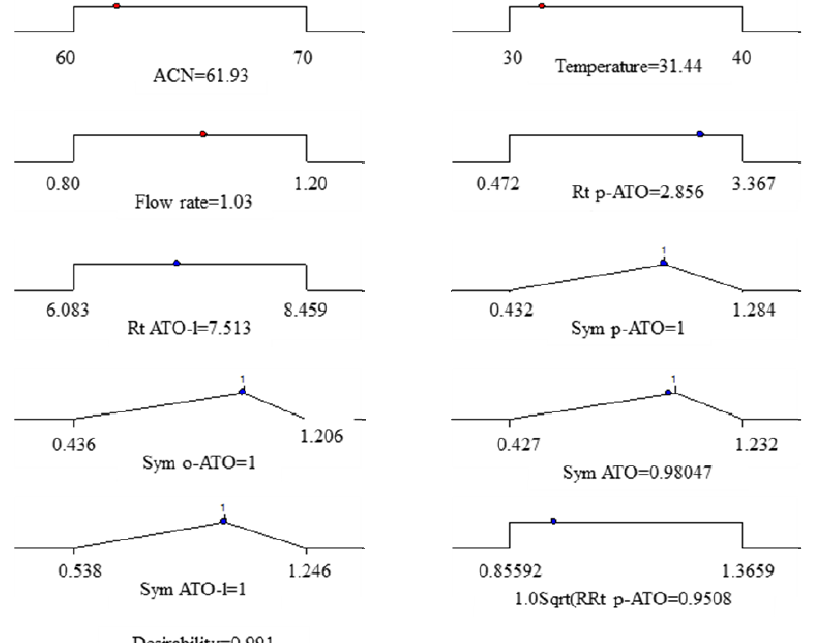
Figure 3. Graphical representation of the constraints accepted fot the determination of global desirabilty and obtained optimal